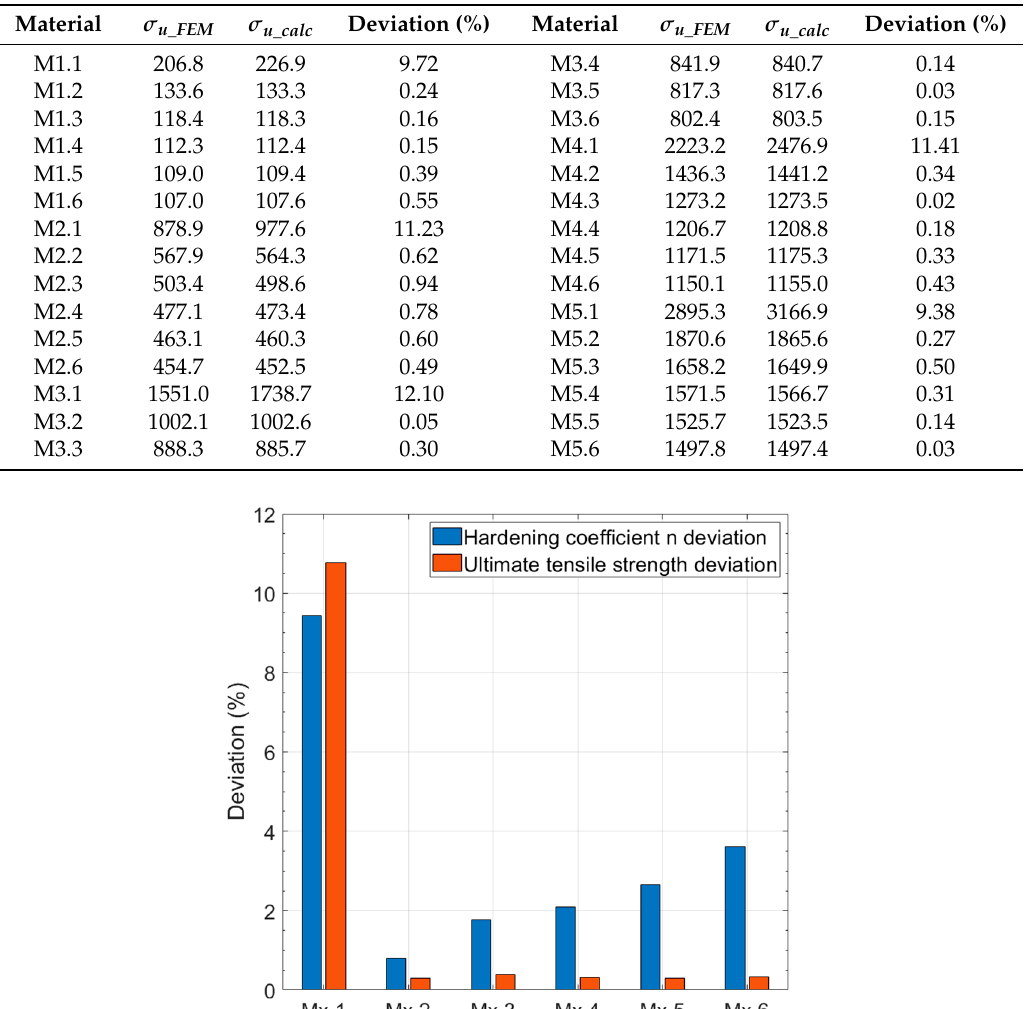
Table 5. Deviations between σ u_calc and σ u_FEM .